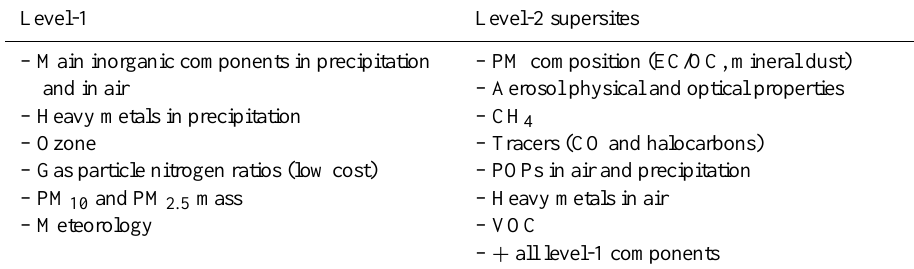
Table 1. General overview of the EMEP monitoring program for the period 2009-2020, (UNECE, 2009).